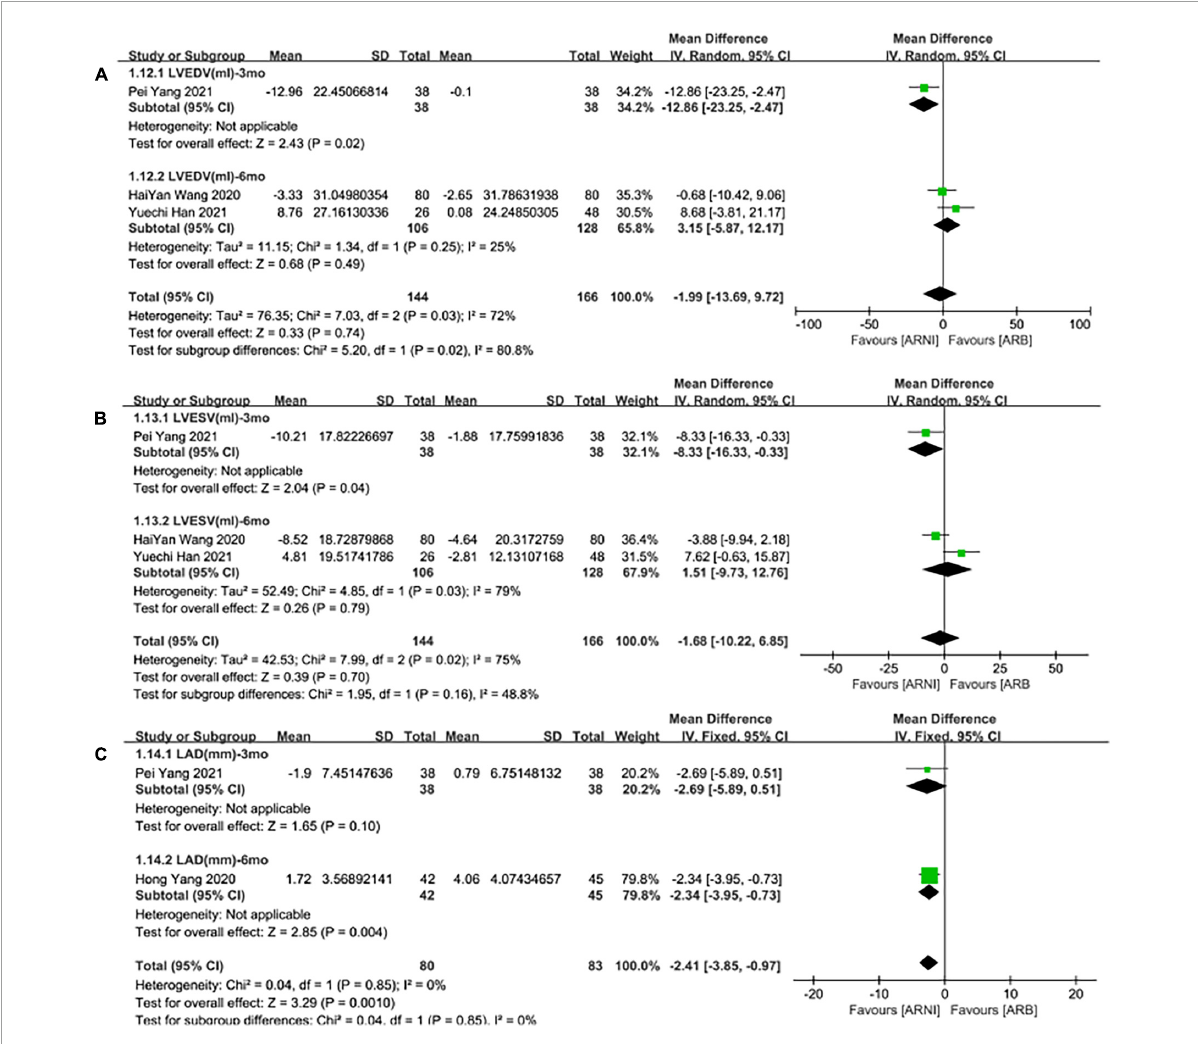
FIGURE8 Subgroup analysis of ARNI effects on CRR indices in contrast with ARBs according to follow-up periods (2). (A) Subgroup analysis on left ventricular end-diastolic volume, (B) subgroup analysis on left ventricular end-systolic volume, and (C) subgroup analysis on left atrial